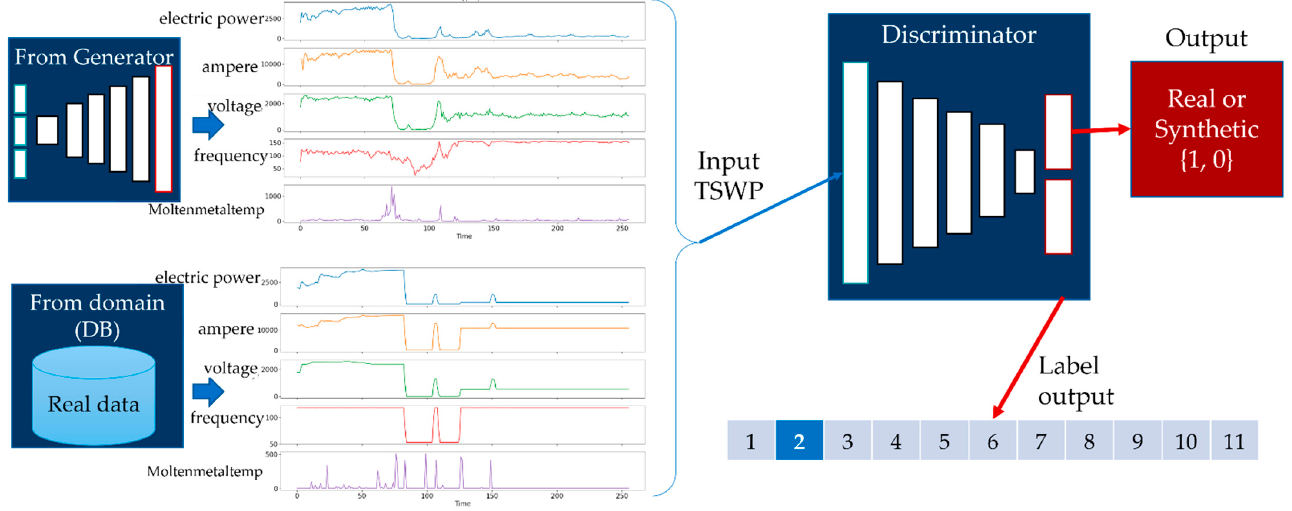
Figure 5. The discriminator model of AC ‐ GAN for the melting process.